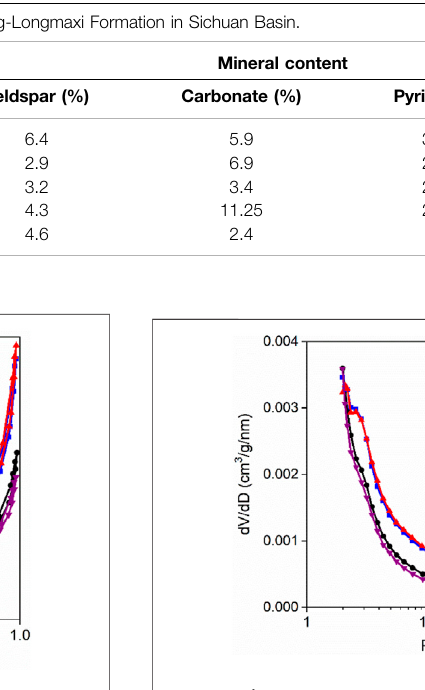
FIGURE 4 | Low-pressure nitrogen adsorption-desorption isotherms of representative shale samples from well Anye A well platform.